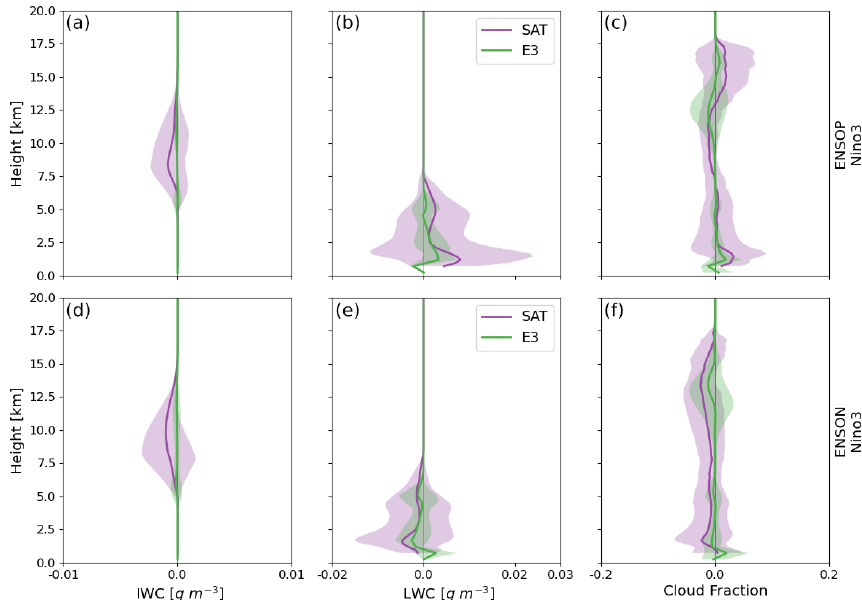
Figure 13. Same as Fig. 12 but averaged over the Niño3